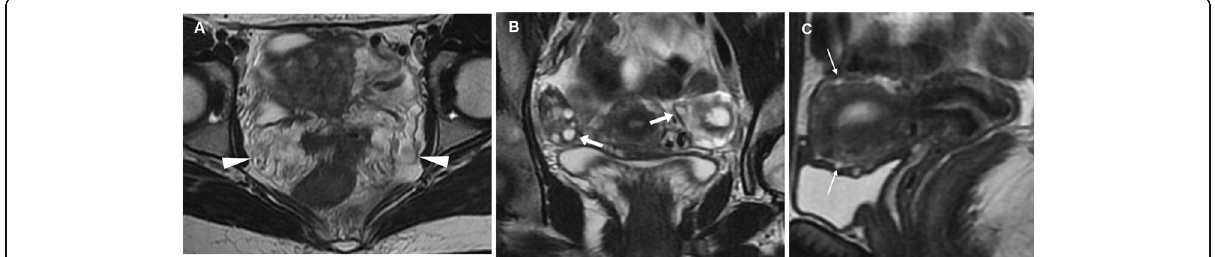
Fig. 24 In the same patient as in Fig. 22, multiplanar T2-weighted images demonstrate severely congested pelvic veins (arrowheads in a ), cystic components in both ovaries (arrows in b ), and dilated arcuate veins in the subserosal portion of the myometrium (thin arrows in c